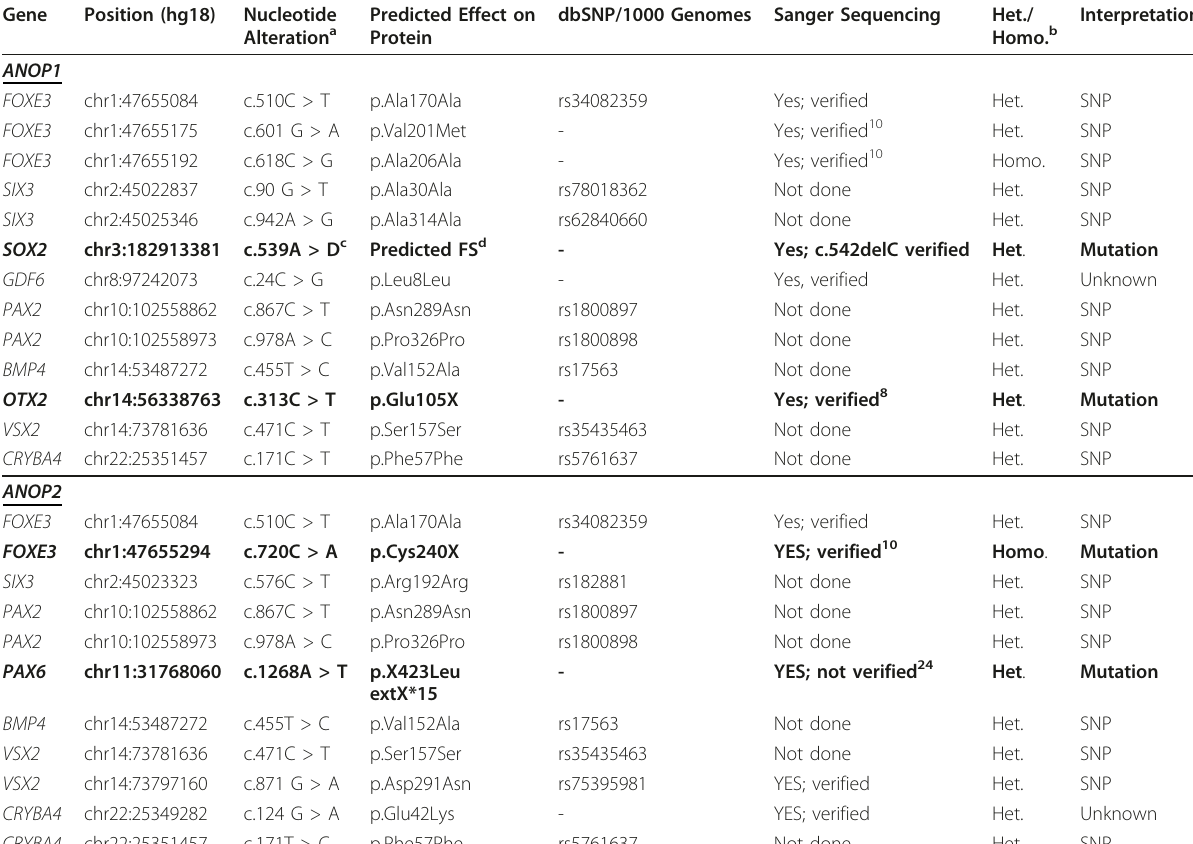
Table 3 Coding Sequence Variants Predicted by Syzygy and Verified by Sanger Sequencing in the ANOP1 and ANOP2